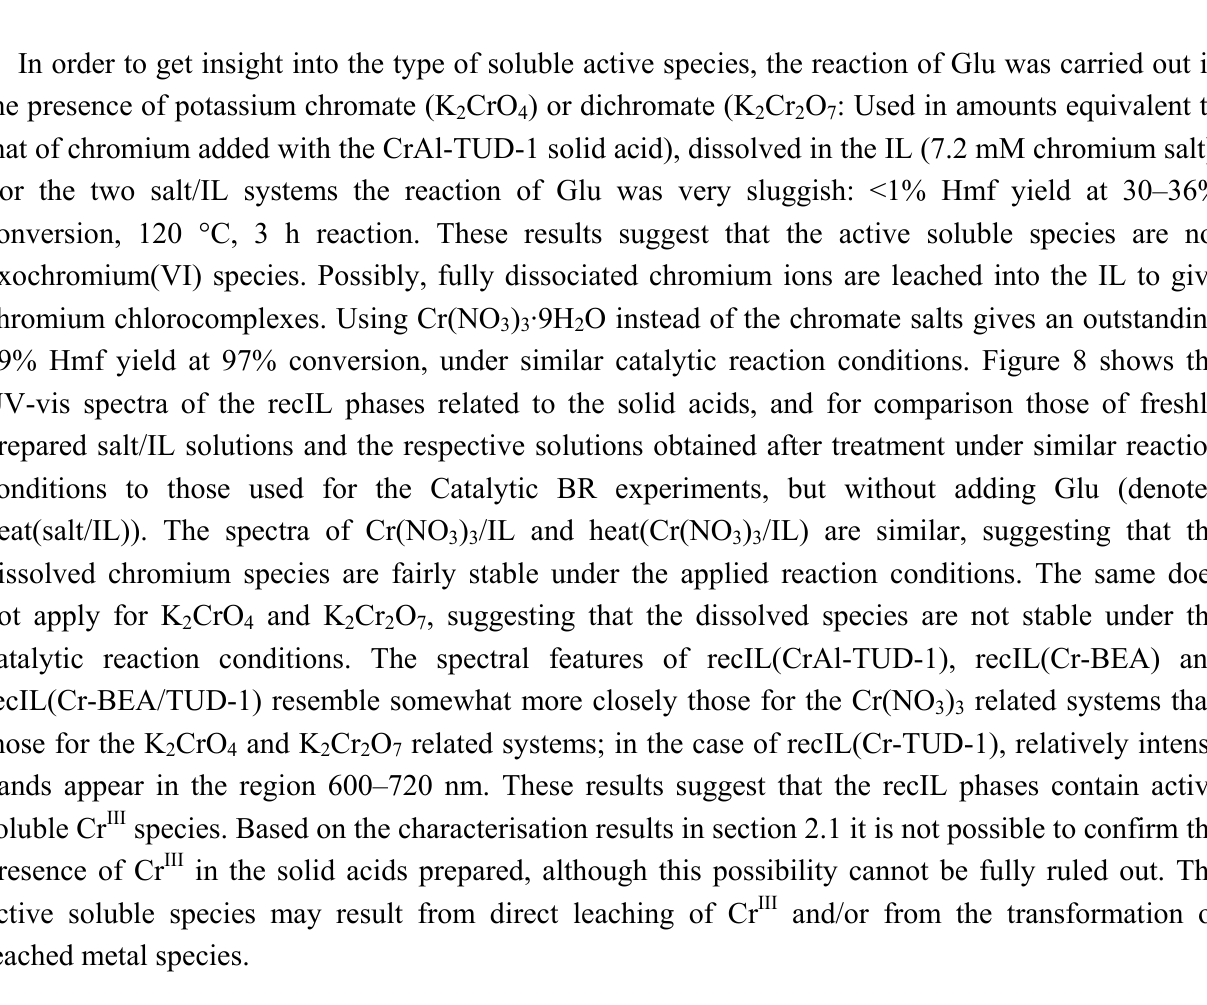
Figure 8. UV-vis spectra of the recIL phases related to the chromium-containing solids, and of chromium salts dissolved in the IL ([bmim]Cl) before and after heating at 120 °C for 3